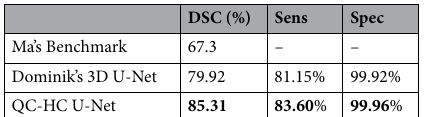
Table 1. Comparison of segmentation indexes of COVID-19 pulmonary